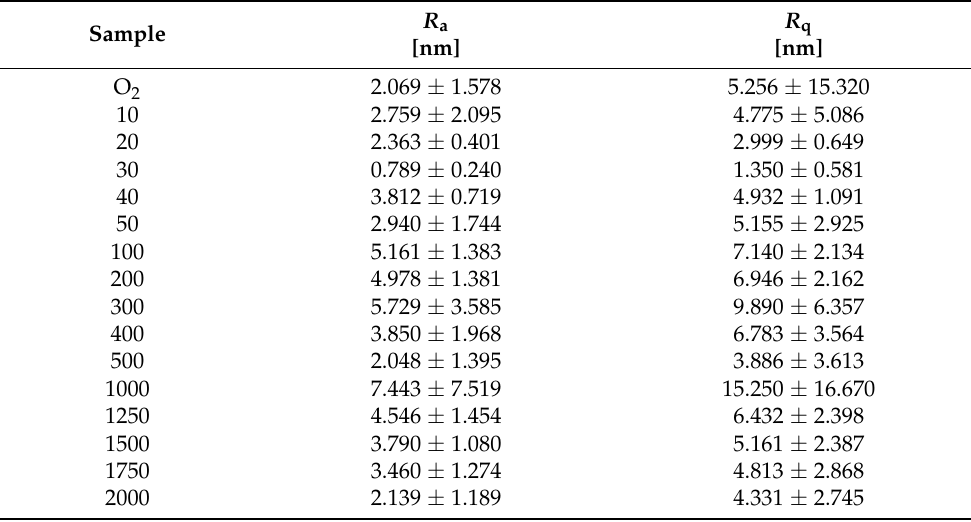
Figure 3. AFM 3D-images for the O 2 plasma-treated PC sample ( a ) and PC coated with thin a-C:H layers from 10 nm ( b ) to 100 nm ( g ). Table 1. AFM roughness values R a and R q : analyzed are the O 2 plasma-treated PC sample and PC samples coated with a-C:H layers of various thickness in ascending order.